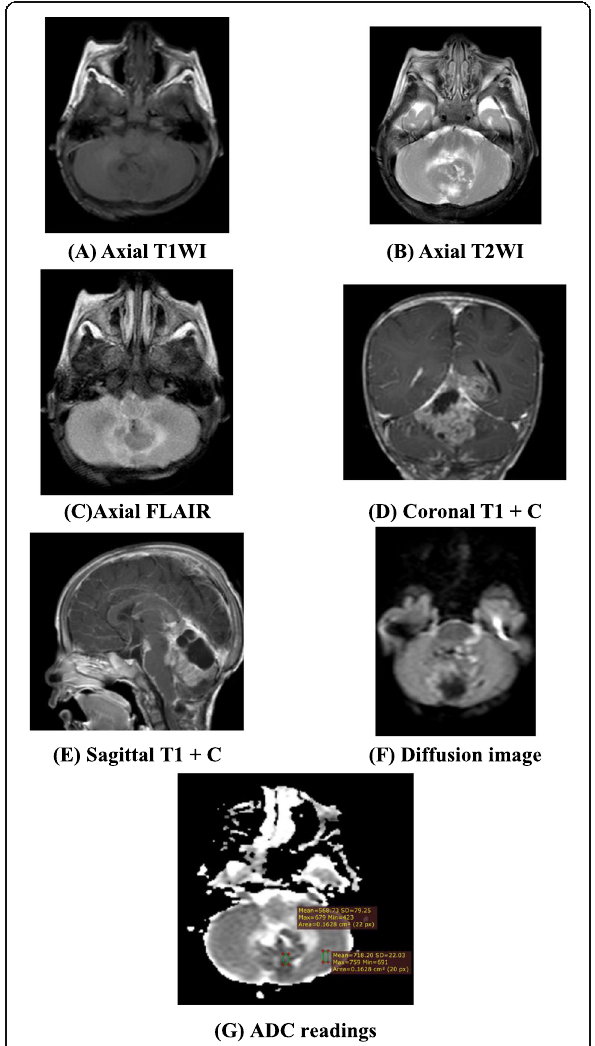
Fig. 5 A 7-year-old female patient complaining of headache and vomiting. Axial T1 ( a ), axial T2 ( b ), axial FLAIR ( c ), coronal T1 post contrast ( d ), sagittal T1 post-contrast ( e ) — posterior fossa SOL seen within fourth ventricle, extending to the right cerebellar hemisphere and right cerebellopontine angle. The mass measured 47 × 35 × 36 mm at its maximum AP, width, and CC diameters, it showed heterogeneous predominantly low SI at T1WI ( a ), high SI at T2 ( b ), and FLAIR sequence ( c ) with central breakdown, avid, and heterogenous enhancement after IV contrast injection ( d ), ( e ). Axial DWI ( f ), axial ADC ( g ) — the lesion showed restricted diffusion, ADC ratio — 1.3, ADC values of the lesion — (1.006, 1.081, 1.087) × 10 3 mm 2 /s × 103 mm2/s, average 1.081 × 103, ADC value of the normal